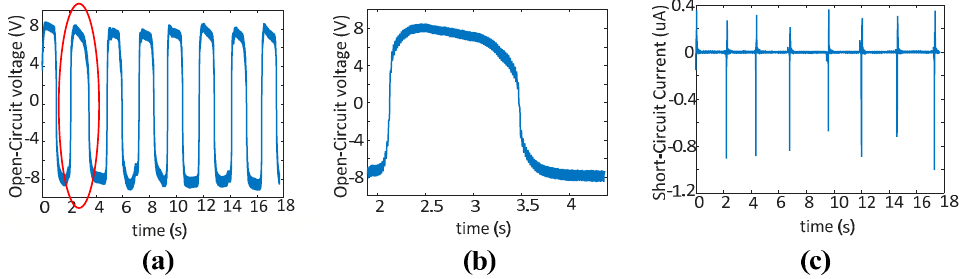
Figure 7. Open-circuit voltage and short-circuit current of the triboelectric energy harvester (PTFE and copper, pressing model). ( a ) The open-circuit voltage; ( b ) the enlarged figure of one period in ( a ); ( c ) short-circuit current.